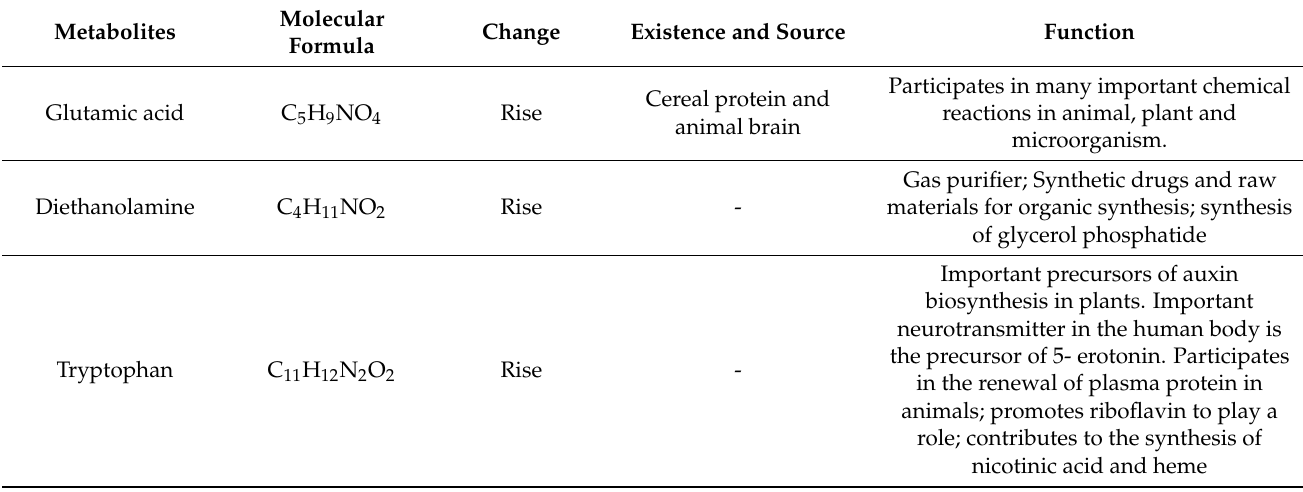
Table 4. Differential metabolite